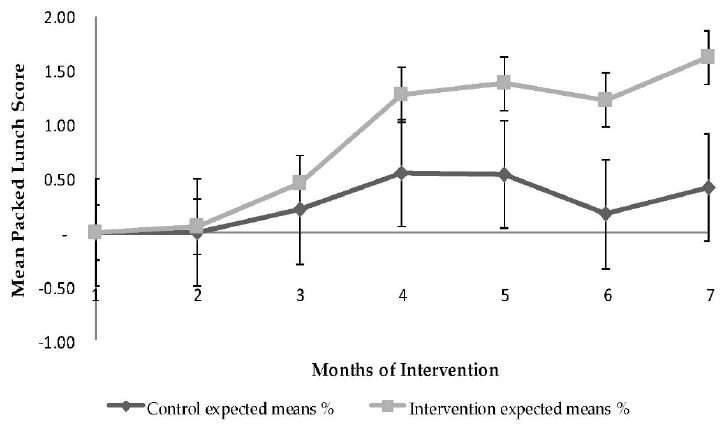
Figure 3. Changes in packed lunch score by study arm during a single school year. p -value was generated from the GEE model and represents p -values for intervention arm, time, and interaction between time and arm. Generalized estimating equations (GEE) were used to evaluate the changes in packed lunch score over time, with the control arm as the reference. Vertical bars indicate 95% CI.